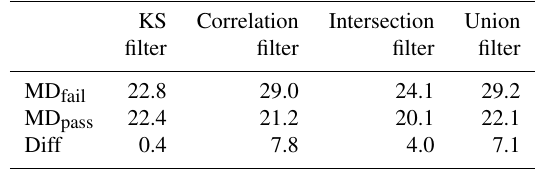
Table 3. Mean distance (MD) of four tests averaged over 457 days of cold season. Diff is the difference between the first and second